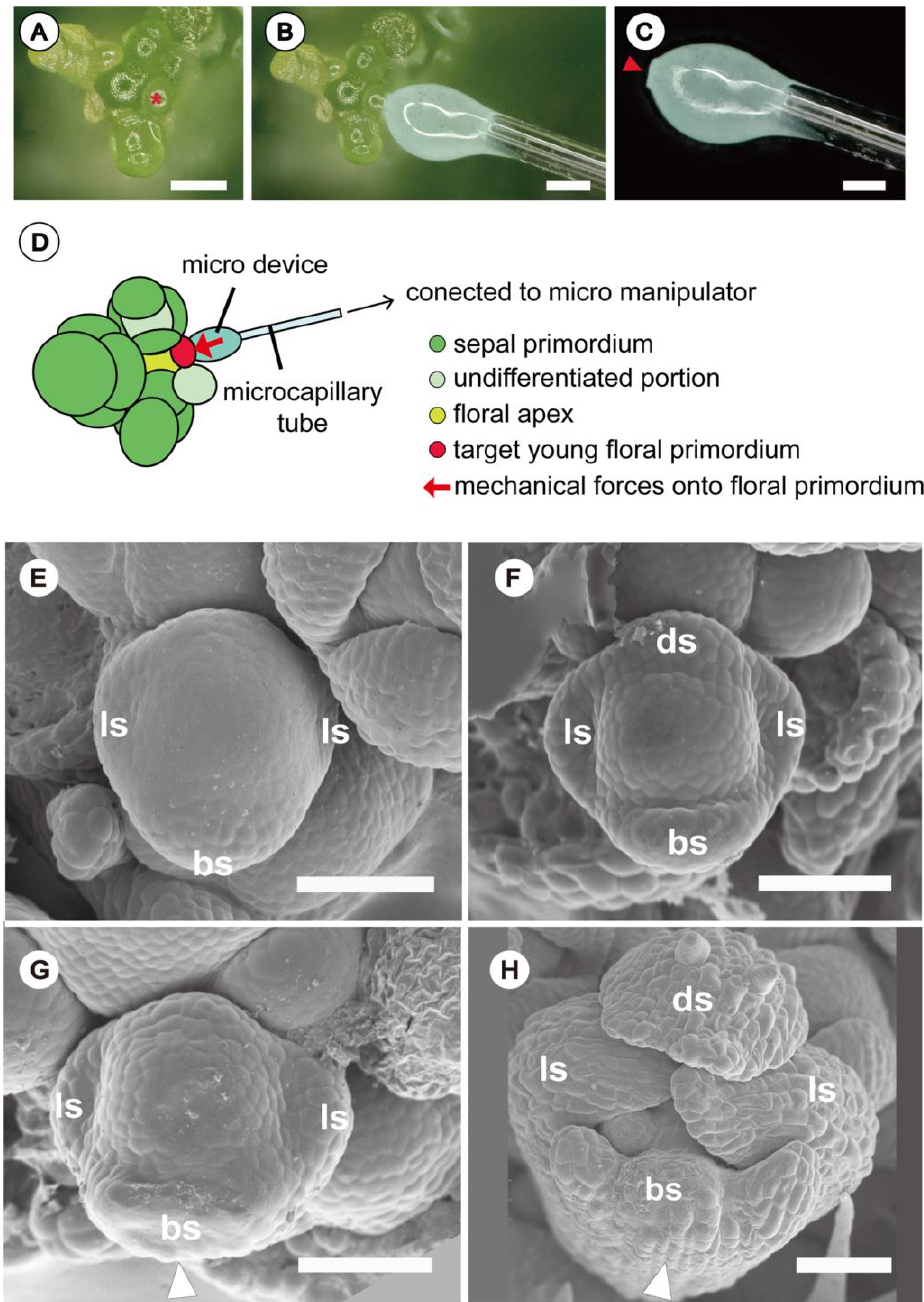
Figure 4. Novel experimental system with mechanical forces on a floral primordium of Arabidopsis thaliana : ( A ) dissected floral apex of Arabidopsis thaliana with a young primordium shown (*) prior to floral organ initiation. ( B ) Apex undergoing contact of unsolidified silicone paste on young floral primordium. After solidification of silicone paste, it becomes separated from floral primordium. ( C ) Separated silicone microdevice. Arrow indicates part that fits abaxial side of young floral pri- mordium. ( D ) Schematic diagram of experimental system with effect of mechanical forces on floral primordium. Silicon microdevice ( B , C ) is pressed against abaxial side of floral primordium for more than 40 h to induce a mechanical force (several hundred µ N). ( E ) Floral primordium at early stage without any external mechanical force. Abaxial and two lateral sepal primordia are initiated. ( F ) Floral primordium at a slightly later stage than that in ( D ). 3Abaxial and two lateral sepal primordia develop further, and an adaxial sepal primordium is initiated. ( G ) Floral primordium at an early stage